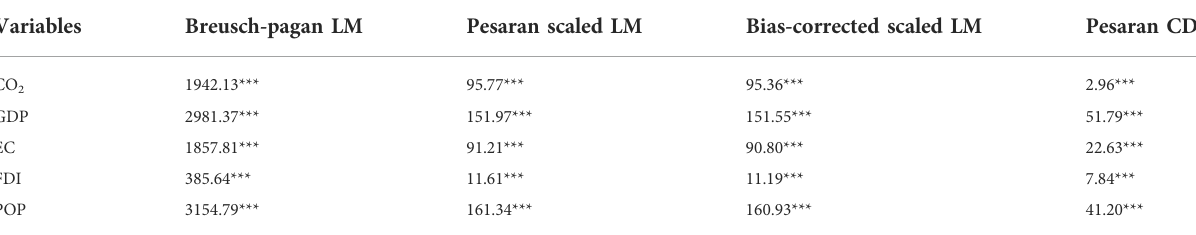
TABLE 4 Results of cross-sectional dependence